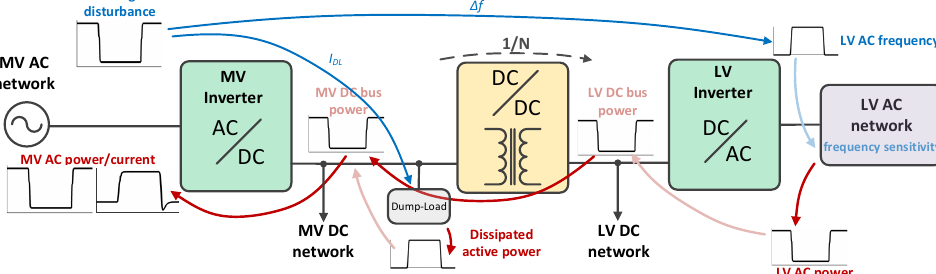
Figure 14. Overview of the cascading effects resulting from the proposed FRT control strategy during a net generation scenario in the ST’s hybrid AC/DC grid, following a voltage sag in the MV AC